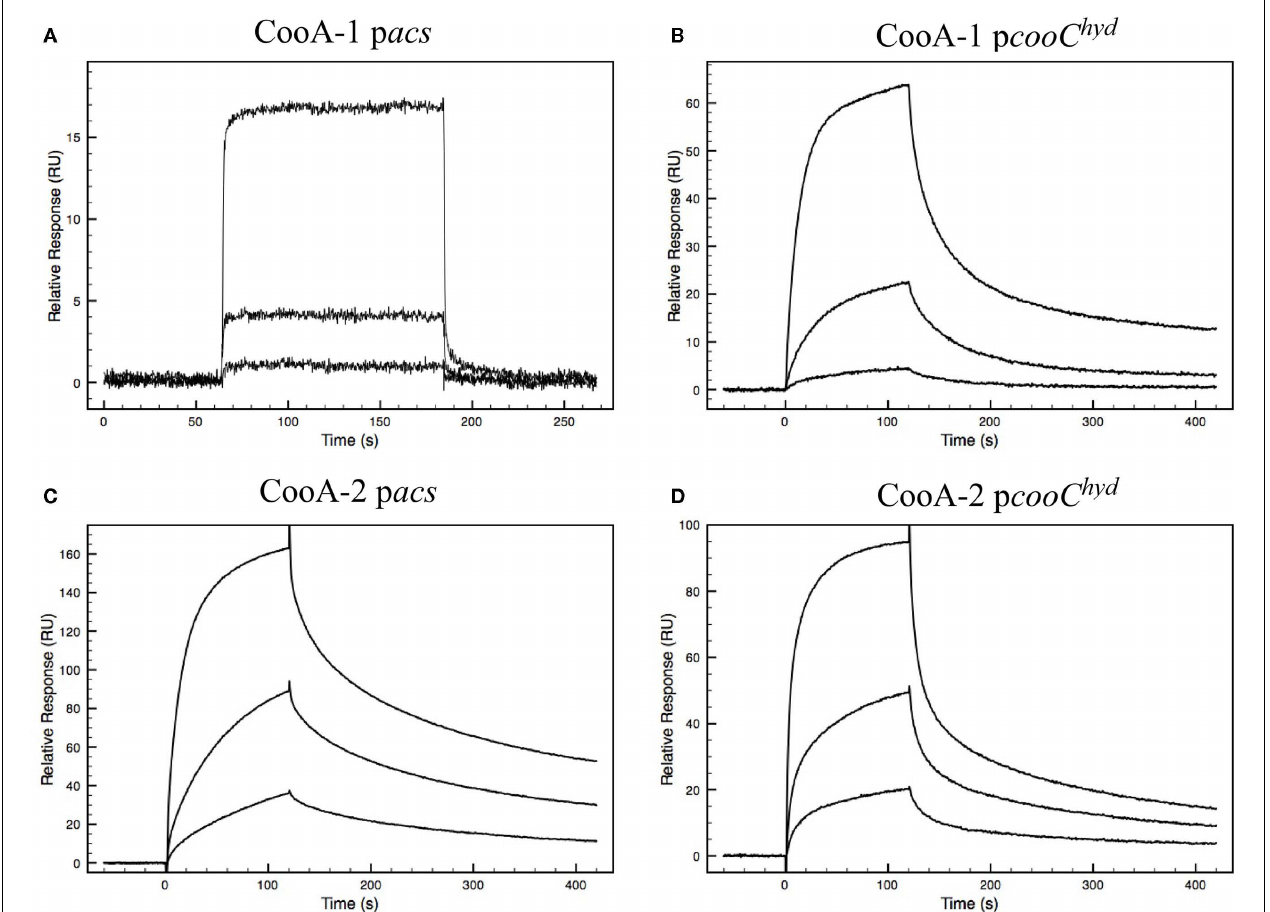
used were 8, 40, and 200nM for CooA-1 and 12, 40, and 200nM for CooA-2. (A) CooA-1 binding to the p acs promoter fragment. (B) CooA-1 binding to the p cooC hyd promoter fragment. (C) CooA-2 binding to the p acs promoter fragment. (D) CooA-2 binding to the p cooC hyd promoter fragment.